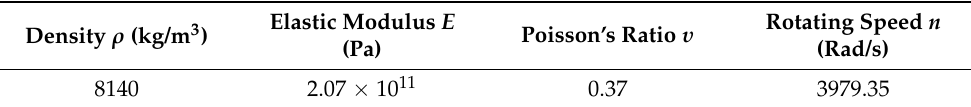
Table 4. The material properties of GH720Li at 650 ◦ C and the boundary